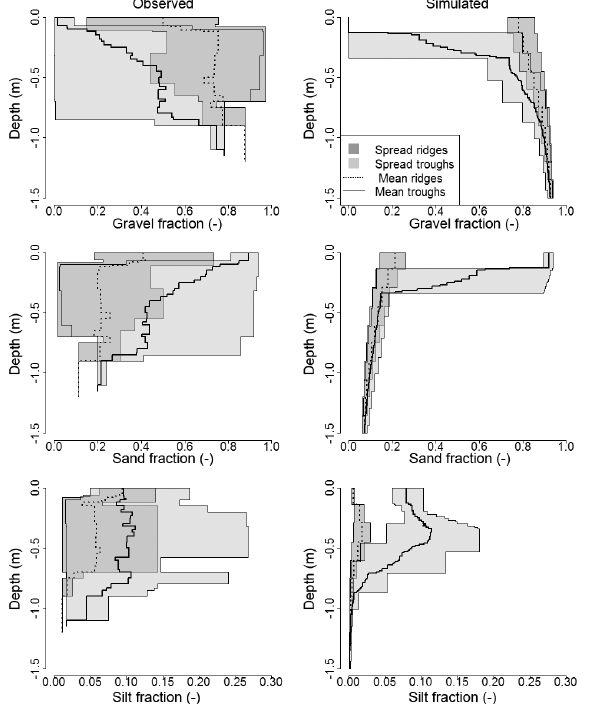
Figure 7. Total variation and mean of particle fractions in observed and simulated profile curves, divided over the morphological set- ting. For every centimetre along the soil profile depth, the minimum, maximum and mean mass fraction of the various grain sizes for all profiles in the considered morphological setting are